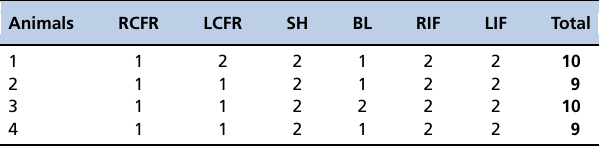
Table 1 - Abdominal Fluid Distribution Score assessed from CT images.